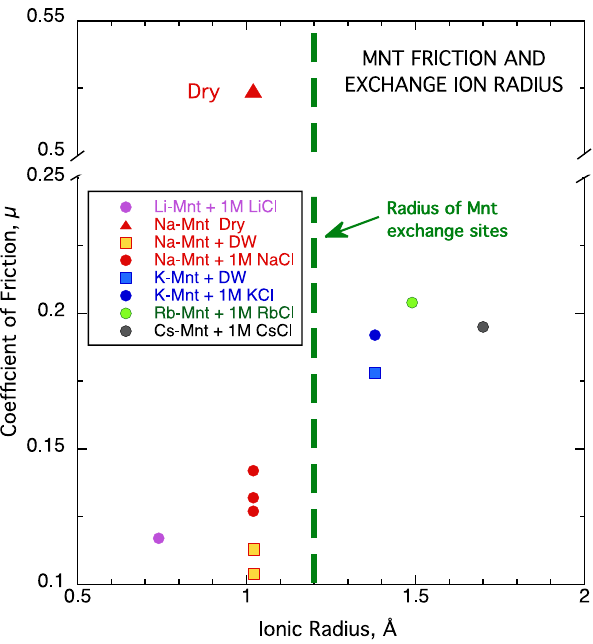
Fig. 1 Friction coef fi cient of Li-, Na-, K-, Rb-, and Cs-montmorillonites (Mnt) under dry and wet conditions. Friction coef fi cients are measured by triaxial shear experiments at effective normal stress of 40 MPa, both dry and wet, by adding distilled water (DW) or brine (1 M salts). Horizontal axis indicates the ionic radii of interlayer cations determined from six- coordinated anions 46 . A vertical dashed line indicates the radius of ditrigonal Mnt cavities (1.2 Å) calculated from the radius of the cavity (2.6 Å) 47 minus the ionic radius of six-coordinated oxygen ions (1.4 Å) 46 . In the DFT calculations, the size of the cavity was relaxed to be stable depending on the cationic species, but there is no clear difference between Na- and K-Mnts in the radius of the average cavity (2.6